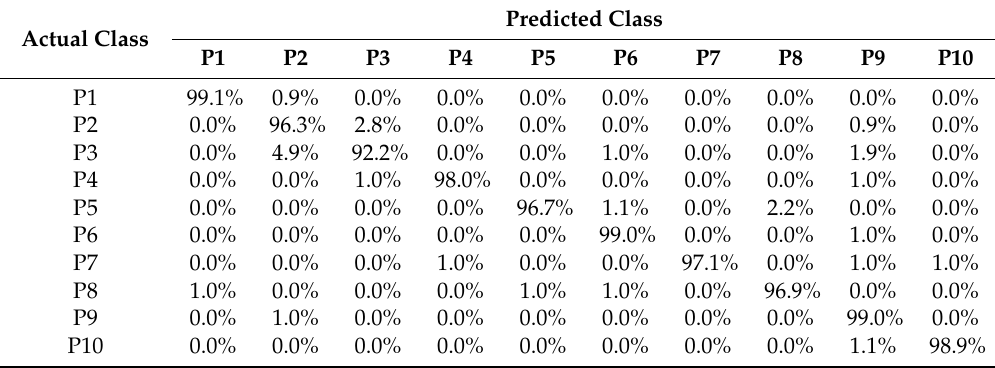
Table 5. The confusion matrix of the proposed classification